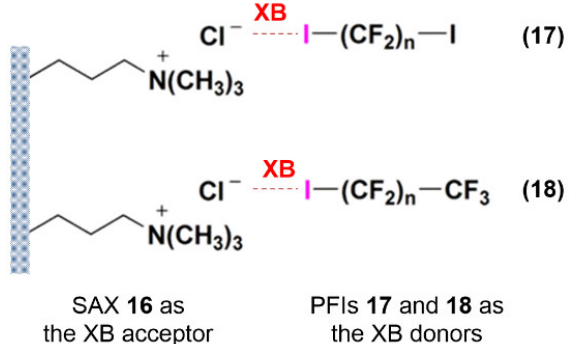
Figure 6. Model for the interaction of iodine (PFIs 17 and 18 ) and Cl − (SAX sorbent 16 ).